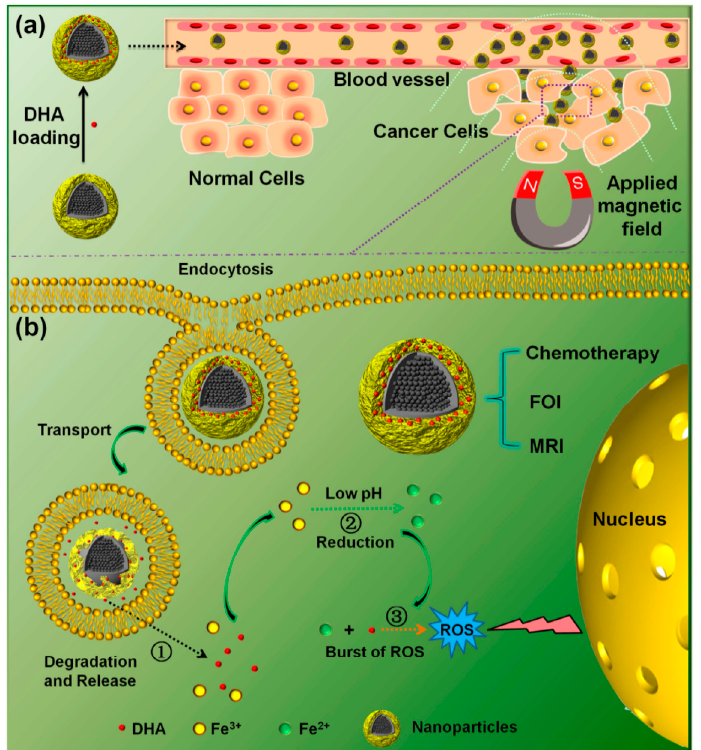
Figure 6. ( a ) Schematic illustration of targeting of dihydroartemisinin (DHA)-loaded Fe 3 O 4 @C@MIL-100(Fe) (FCM) nanoparticles to tumor cells assisted by an externally applied magnetic field; and ( b ) the anticancer mechanism of the DHA delivery system [78].